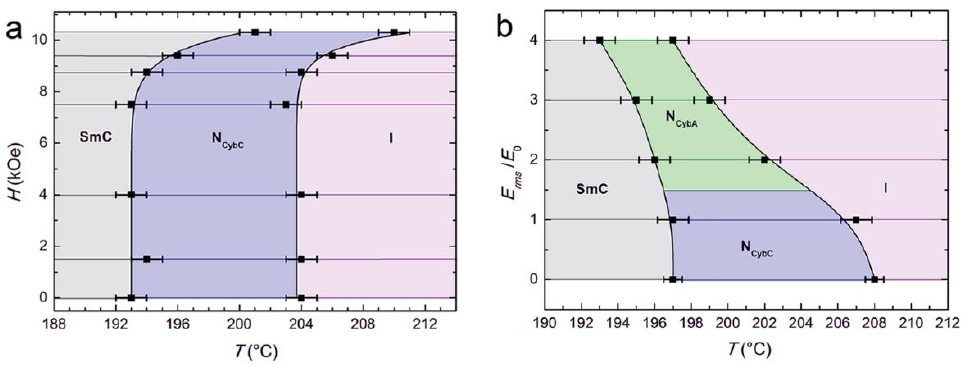
Figure 11. Temperature-field phase diagrams of BCM 1b upon application of ( a ) magnetic and ( b ) electric fields (for the latter, 500 Hz root mean square field values are reported with E 0 = 0.62 V / µ m). Phase boundaries are drawn by interpolating the measured phase transition temperatures (square dots). Reproduced from [16] with permission from The Royal Society of Chemistry.